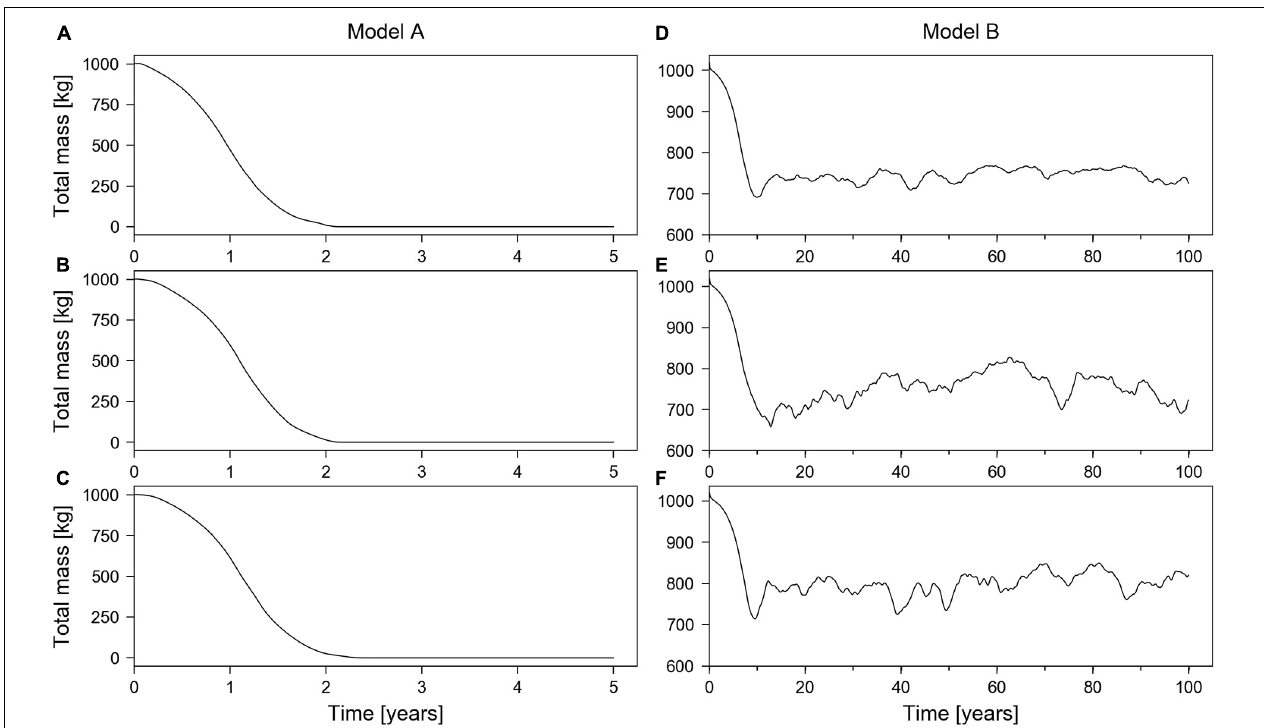
FIGURE 6 | Numerical model results of total solute mass with time. (A,D) Base Case (i.e., α L = 0.1 m; α T = 0.01 m); (B,E) Case 1 (i.e., α L = 0.5 m; α T = 0.05 m); and (C,F) Case 2 (i.e., α L = 1 m; α T = 0.1 m). The left column represents cases of Model A and the right column represents cases of Model